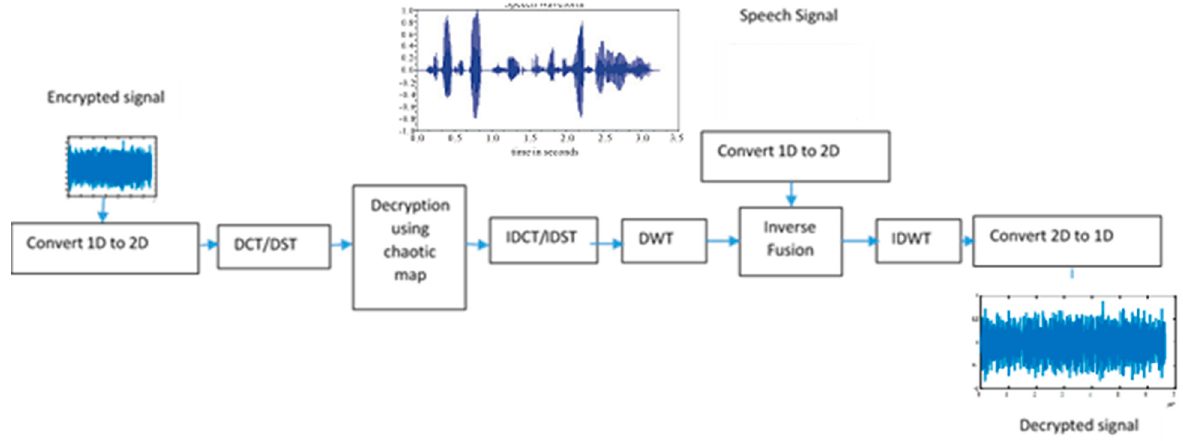
Figure 5. Decryption process of the proposed three layers technique.